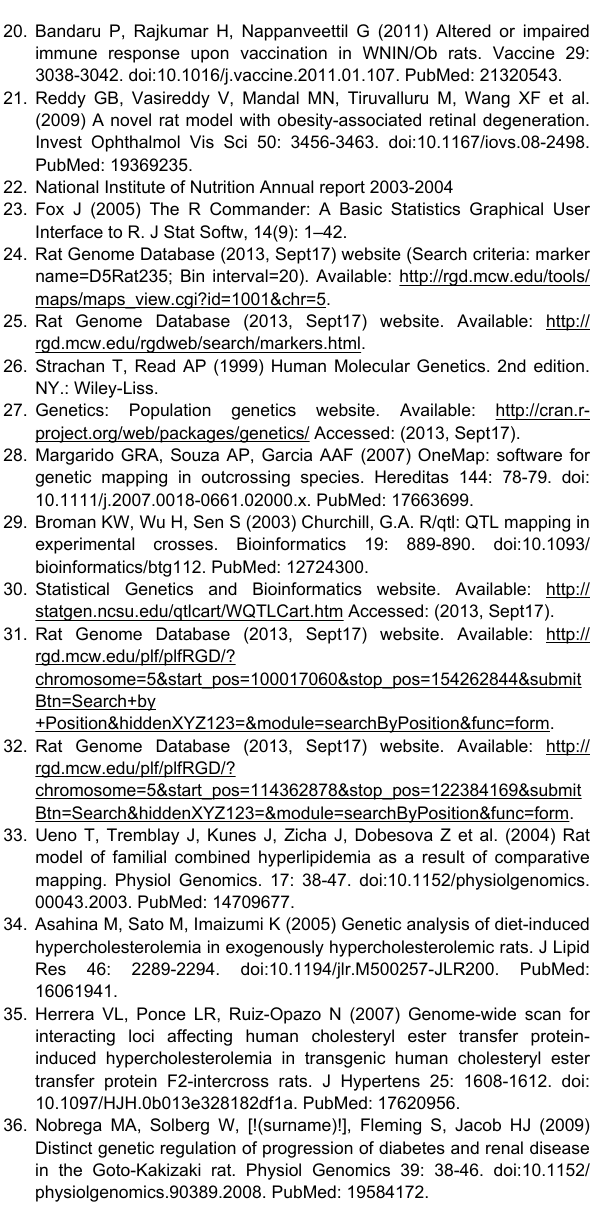
Table S2. Gene annotation - physical versus genetic distance. Physical position of the genes was mined from Rat Genome Database. Physical position is indicated in Million bases (Mb) and represent the centre position of gene ((start position + stop position) /2). Genetic distance (cM)